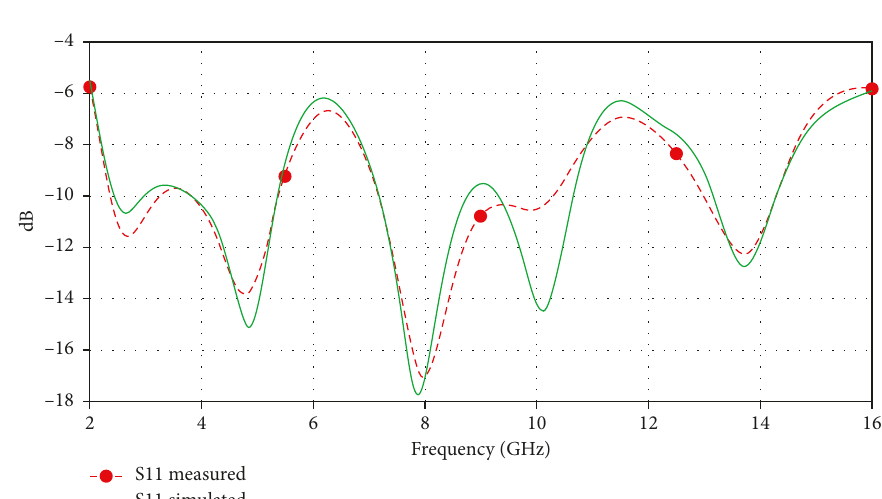
Figure 13: Simulated vs. measured S